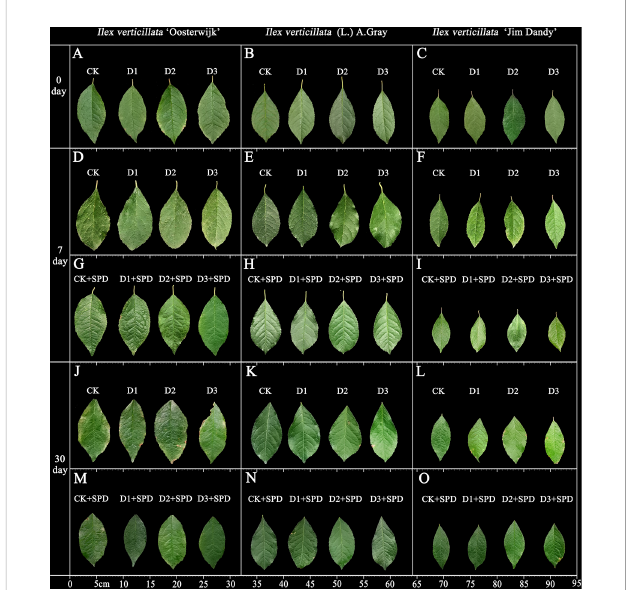
FIGURE 1 The phenotypic changes of Ilex verticillata leaves under drought and spermidine treatments. (A, D, G, J, M) represent the phenotypes of I. verticillata ‘ Oosterwijk ’ leaves. (B, E, H, K, N) represent the phenotypes of I. verticillata (L.) A. Gray leaves. (C, F, I, L, O) represent the phenotypes of I. verticillata ‘ Jim Dandy ’ leaves. A-C represent the phenotypes of the leaves under different treatments on day 0. (D-I) represent the phenotypes of the leaves under different treatments on day 7. (J-O) represent the phenotype of the leaves under different treatments on day 30. CK, control; CK+SPD, control with spermidine; D1, mild drought; D1+SPD, mild drought with spermidine; D2, moderate drought; D2+SPD, moderate drought with spermidine; D3, severe drought; D3+SPD, severe drought with